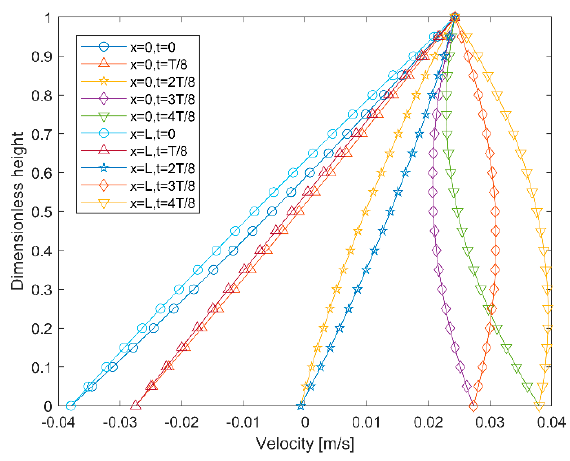
Figure 9. Comparison of velocity profiles at top ( x = 0) and bottom ( x = L ) of film channel in Case A2. Compared to the velocity profile obtained at the center ( x = L/ 2), they show parabolic profiles by the continuity effect as described in Figures 2 and 3. Because of the converging film ( s = − 4.75 × 10 − 4 ) which slope is calculated from the force balance through iterations (Figure 6), positive pressure develops during the downstroke period t down and it pushes the slag flow to both ends (e.g., t = 3 T / 8 or t = 4 T / 8). This continuity or pressure gradient effect promotes the flow at the bottom of slag channel ( x = L ) but interrupts the flow at the top ( x = 0) by bending the velocity profile to parabolic shapes with opposite directions depending on the location. The same mechanism is applicable for explaining the flow during the upstroke period t up with negative pressure (e.g., t = 0).